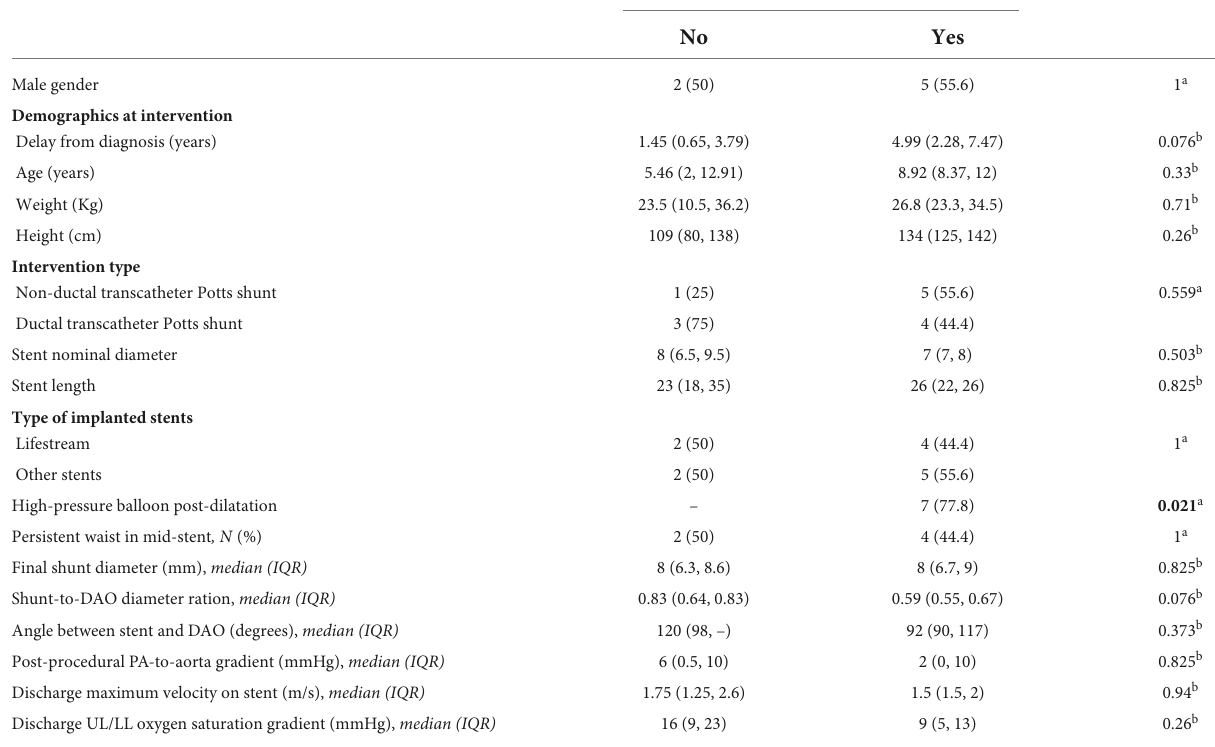
TABLE 4 Distribution of study parameters according to the need for